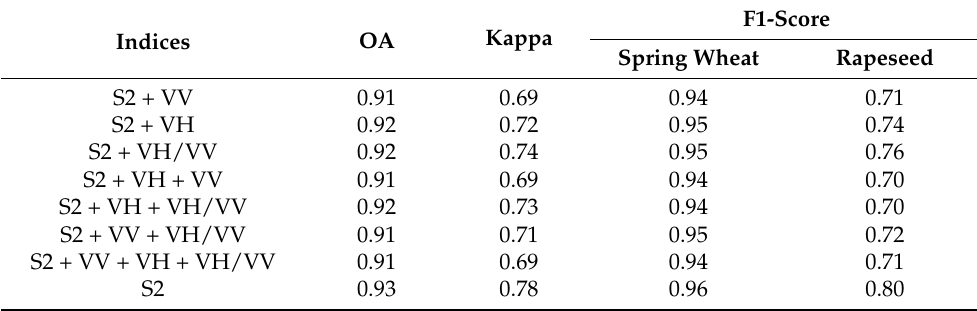
Table 2. Crop-type accuracy of different S1 combinations with S2